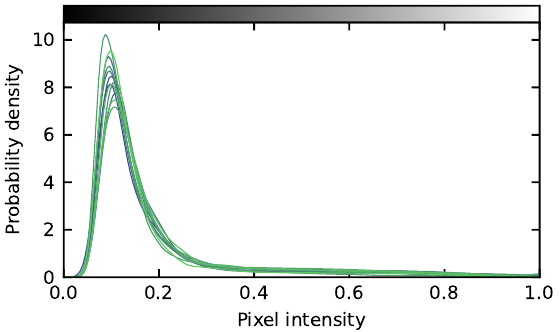
Figure 9. Comparison of histograms of pixel intensities of images of test data set.